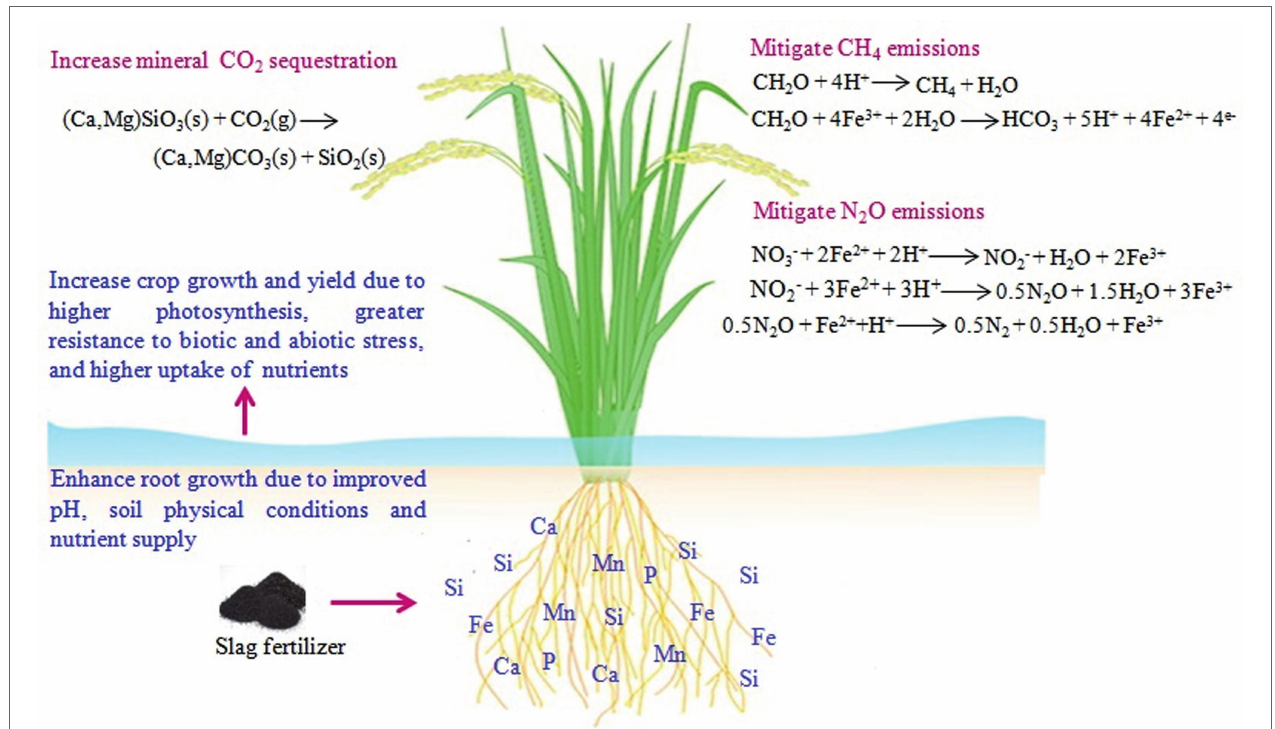
FIGURE 2 | Summary of potential effects of slag on crop